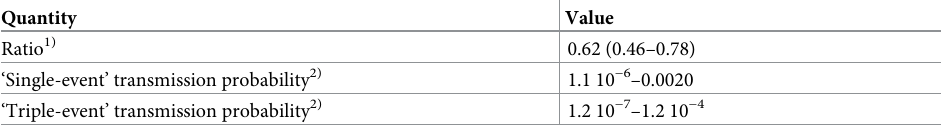
Table 4. The risk of HPAI transmission jumps from one area to another, due to a compartment with one farm located in the DPPA and with transport of animals (chicken) and eggs.